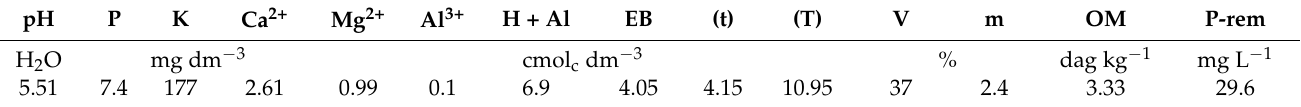
Table 1. Chemical analysis of soil samples collected in the 0–10 cm layers in the experimental